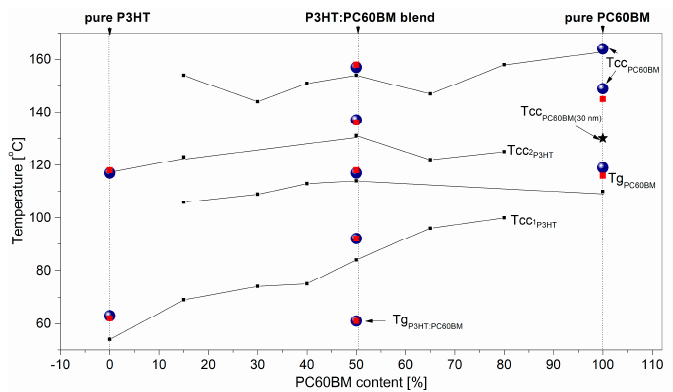
Figure 6. The characteristic temperatures of thermal transitions in P3HT:PC60BM (1:1) films, obtained from resistance and ellipsometric measurements (blue balls and red squares, respectively) added to the phase diagram presented earlier in [61]. The point marked with an asterisk represents the T cc temperature of 30 nm thick PC60BM film.